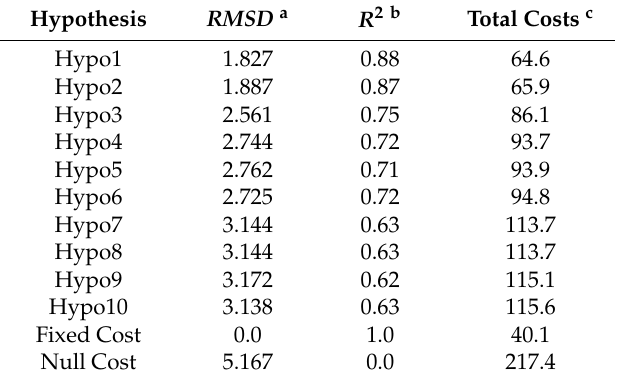
Table 4. Output parameters of 10 generated PH4 pharmacophoric hypotheses for InhA inhibitors after CatScramble validation procedure.